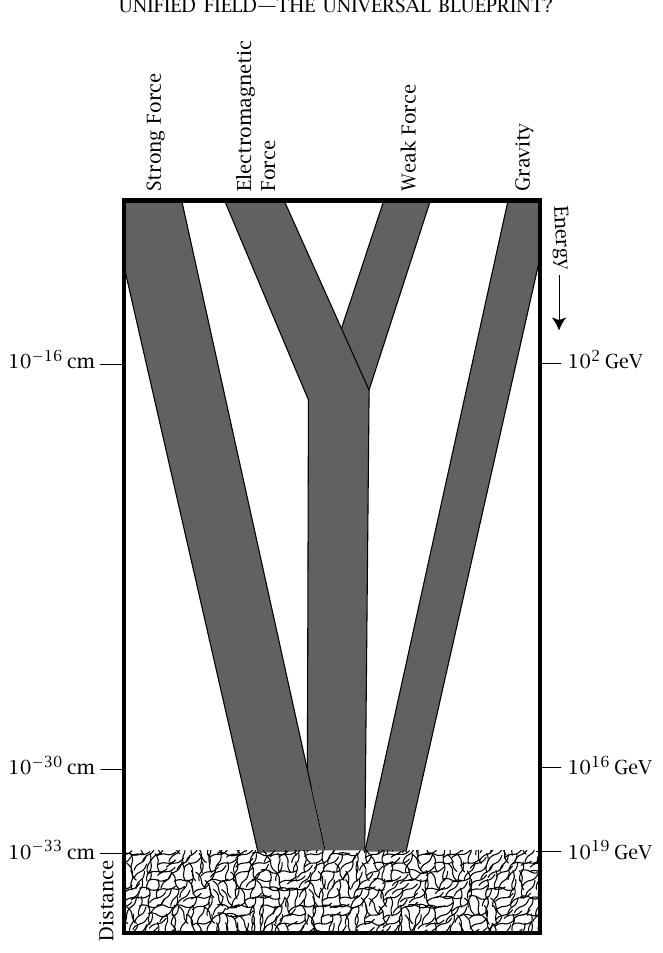
Figure 2 . In the ultimate fabric of space (the Planck’s dimension, 10 − 33 cm), is the unified field, which gradually unfolds resulting in vacuum fluctuations of the various fields as we proceed outward from the fabric of